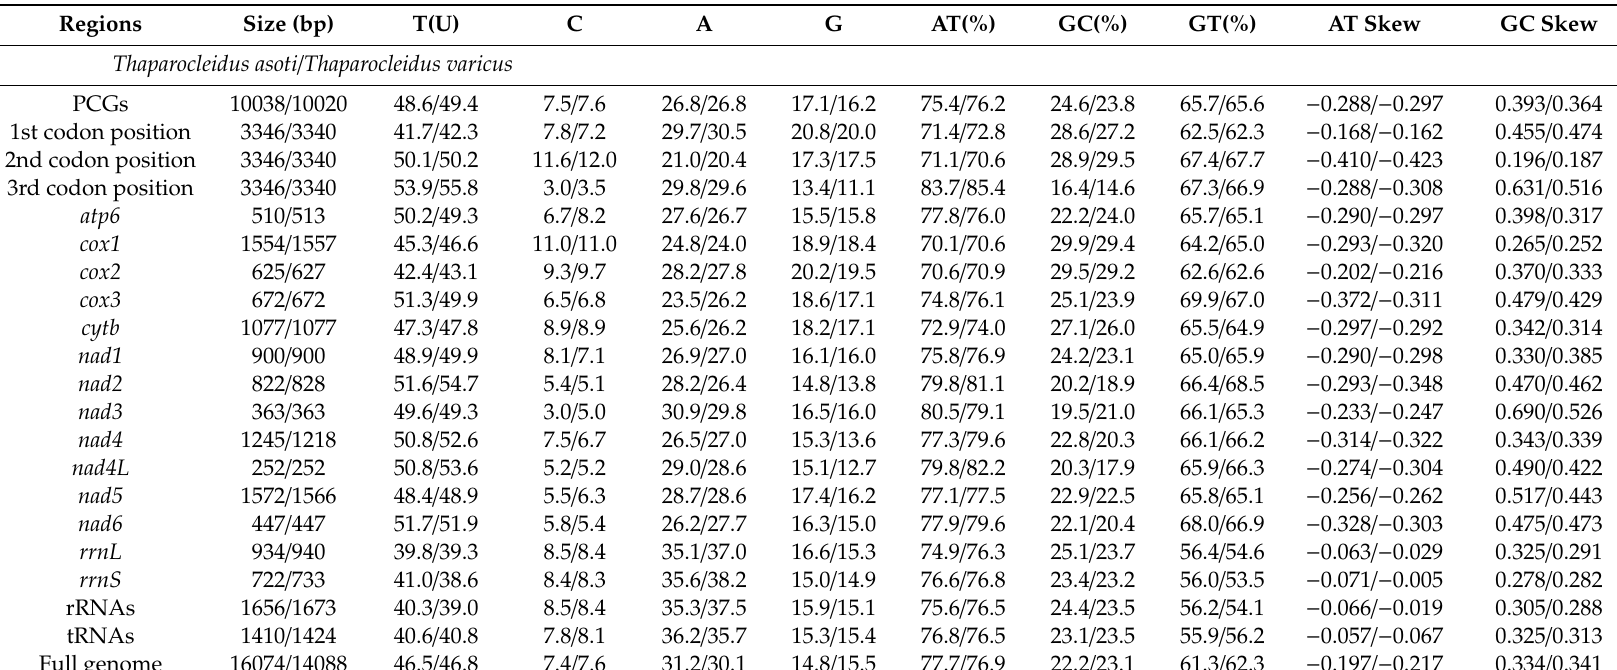
Table 3. Nucleotide composition and skewness comparison of di ff erent elements of the mitochondrial genomes of Thaparocleidus asoti and Thaparocleidus varicus . PCGs: protein-encoding